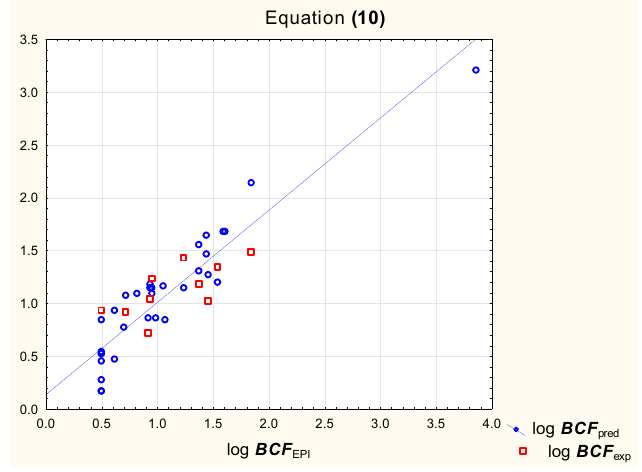
Figure 3. Equation (10)—predicted and experimental log BCF vs. reference values.